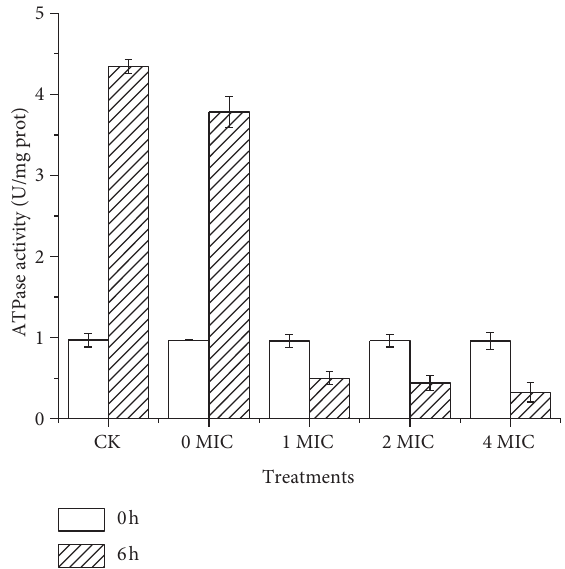
Figure 4: Effect of DMY on the ATPase activity of Pseudomonas